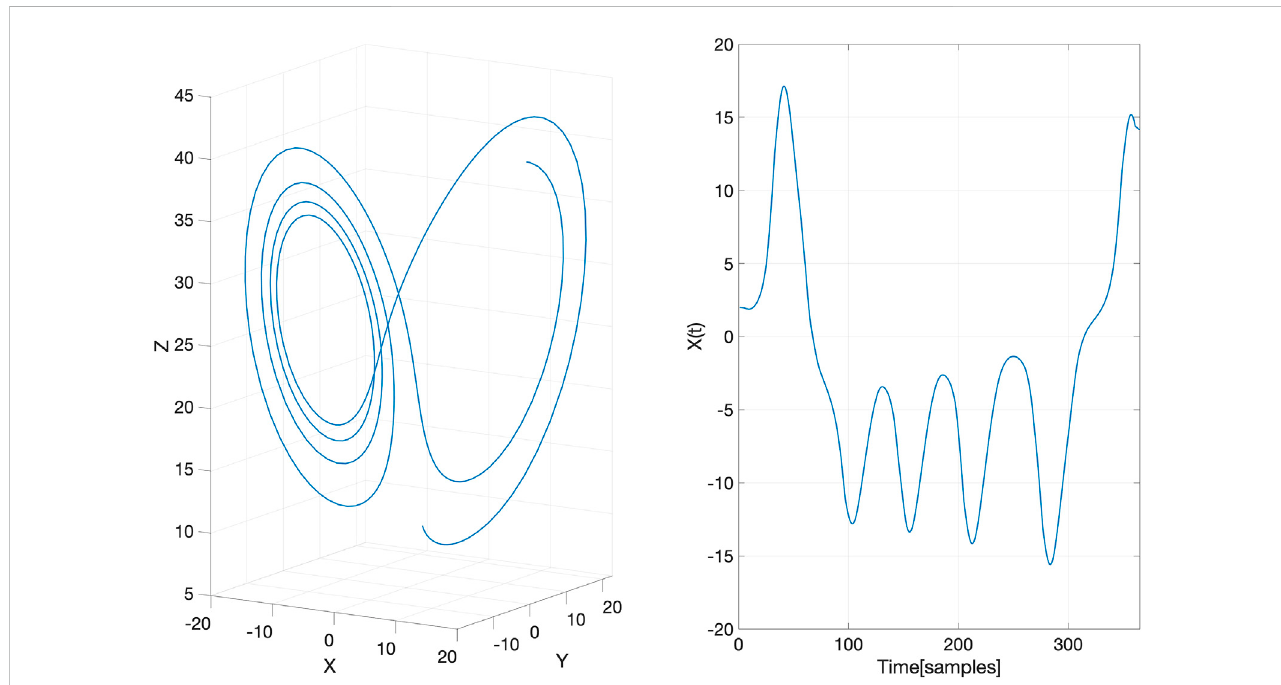
FIGURE 2 The underlying latent Lorenz attractor (left) generated in the toy example and its projection on the X -axis (right).